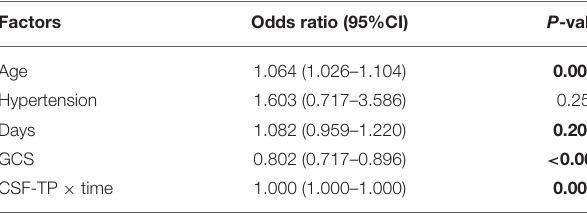
TABLE 2 | Multivariate analysis of important factors.